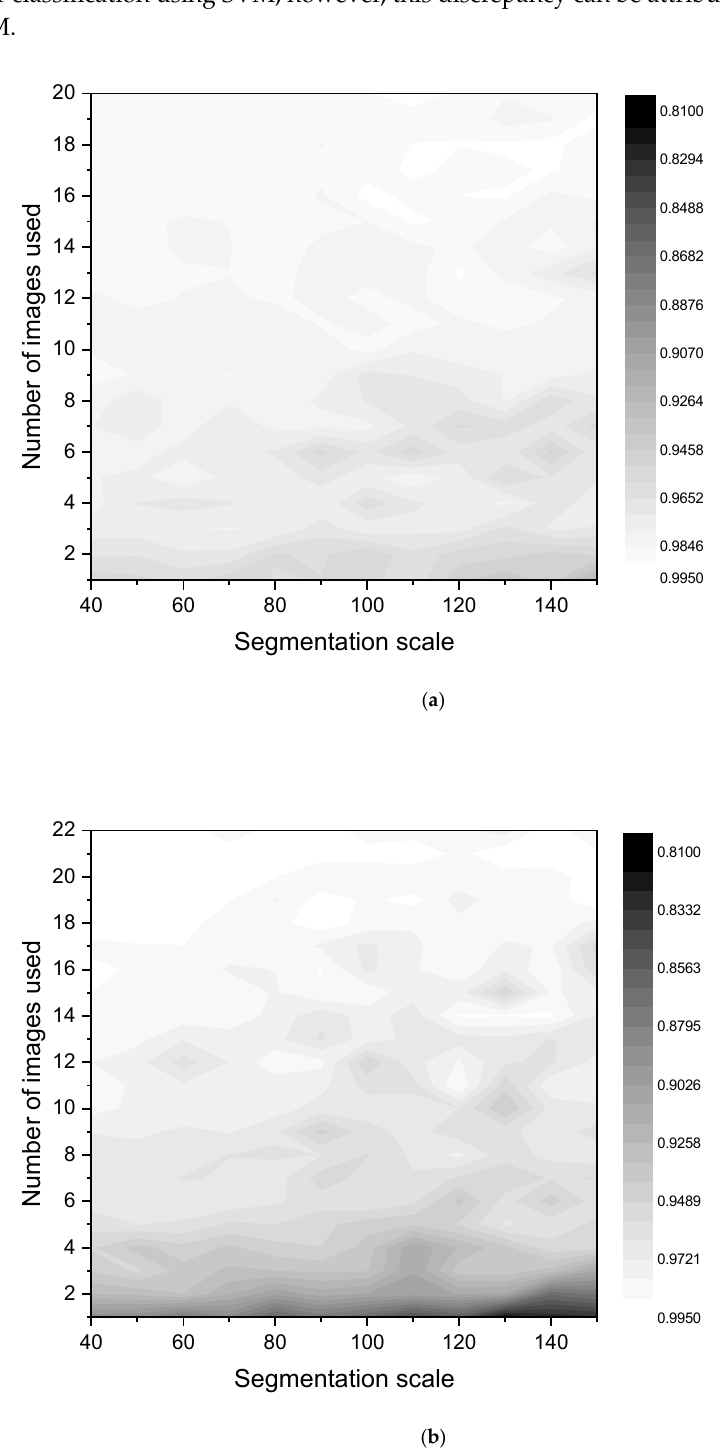
Figure 4. Changes in the overall accuracy (OA) with respect to the segmentation scale and number of images used by random forest (RF) in ( a ) Area 1 and ( b ) Area 2. The x-axis represents the segmentation scale and the y-axis represents the images used.